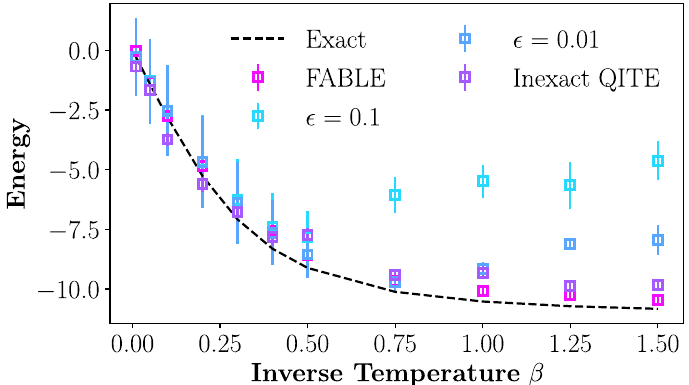
Figure 4. Thermal energy, as a function of inverse temperature β , calculated with TPQ states on a noiseless quantum simulator for a 5-qubit 1D Heisenberg model using FABLE, inexact QITE, and a dilated operator approach to approximate ˆ Q .